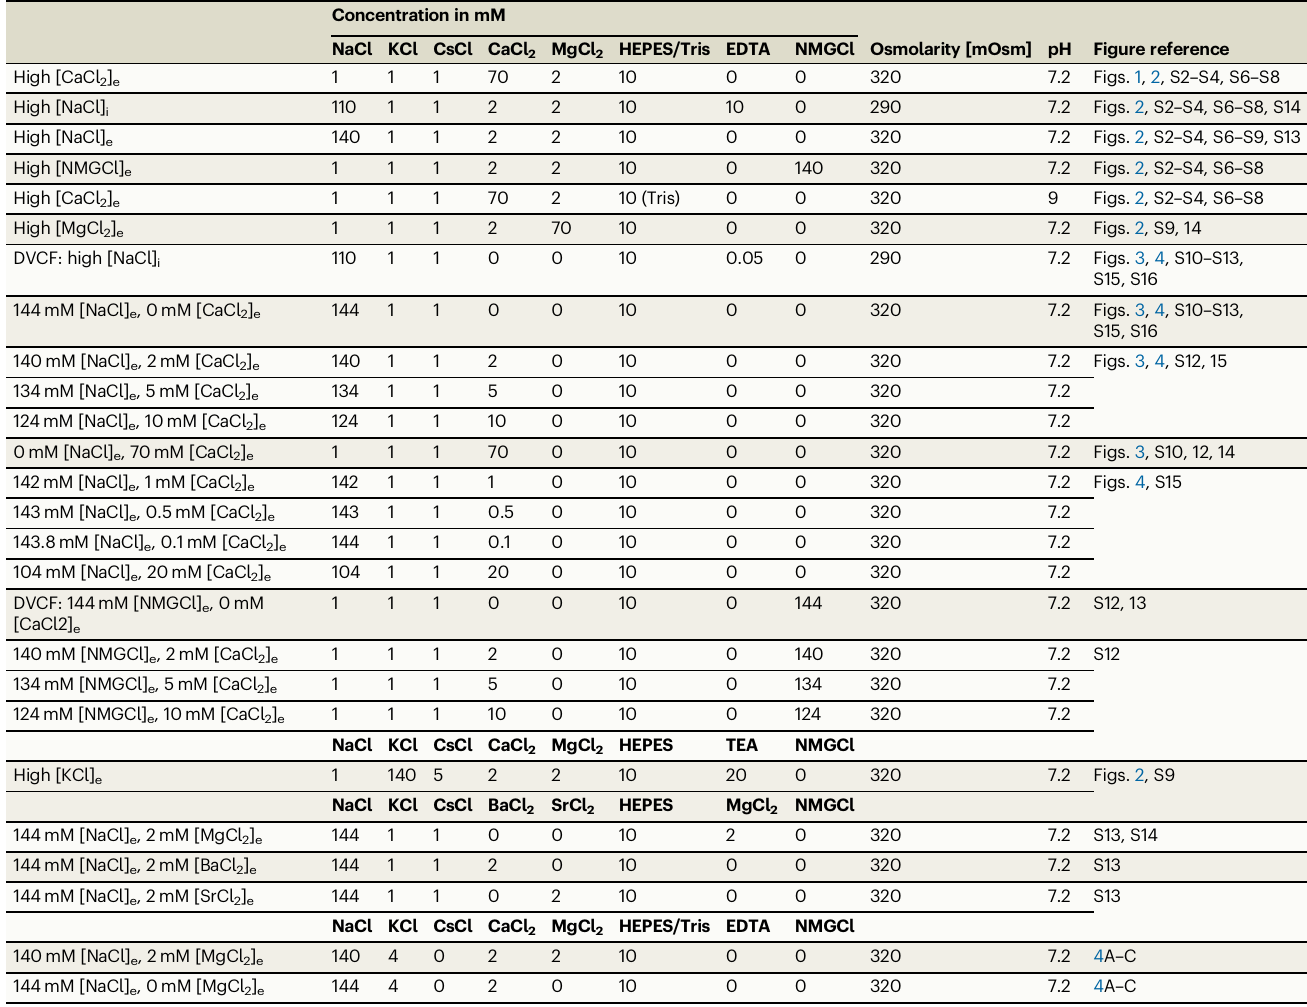
Table 1 | Buffer compositions used in experiments on cultured ND7/23 cells Concentration in